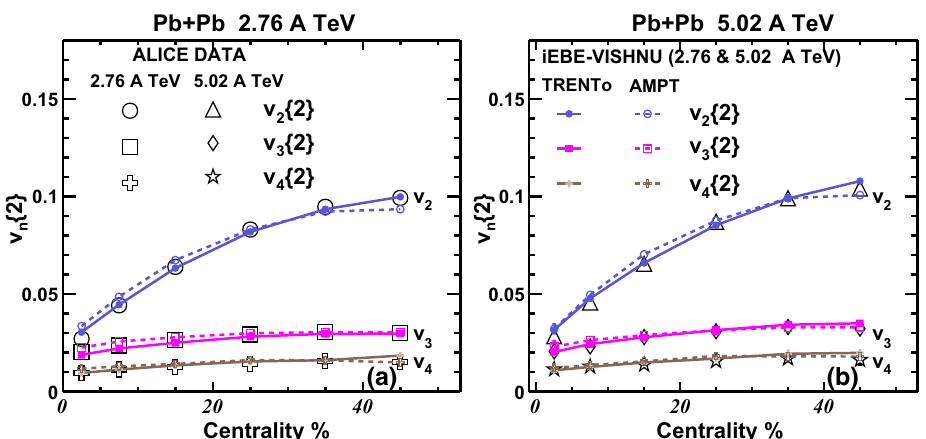
Fig. 4 Integrated flow v n ( n = 2–4) of all charged hadrons in Pb + Pb collisions at 2.76 A TeV (left panel) and 5.02 A TeV (right panel), calculated from iEBE-VISHNU with TRENTo and AMPT initial conditions. The experimental data are taken from [20,52], respectively